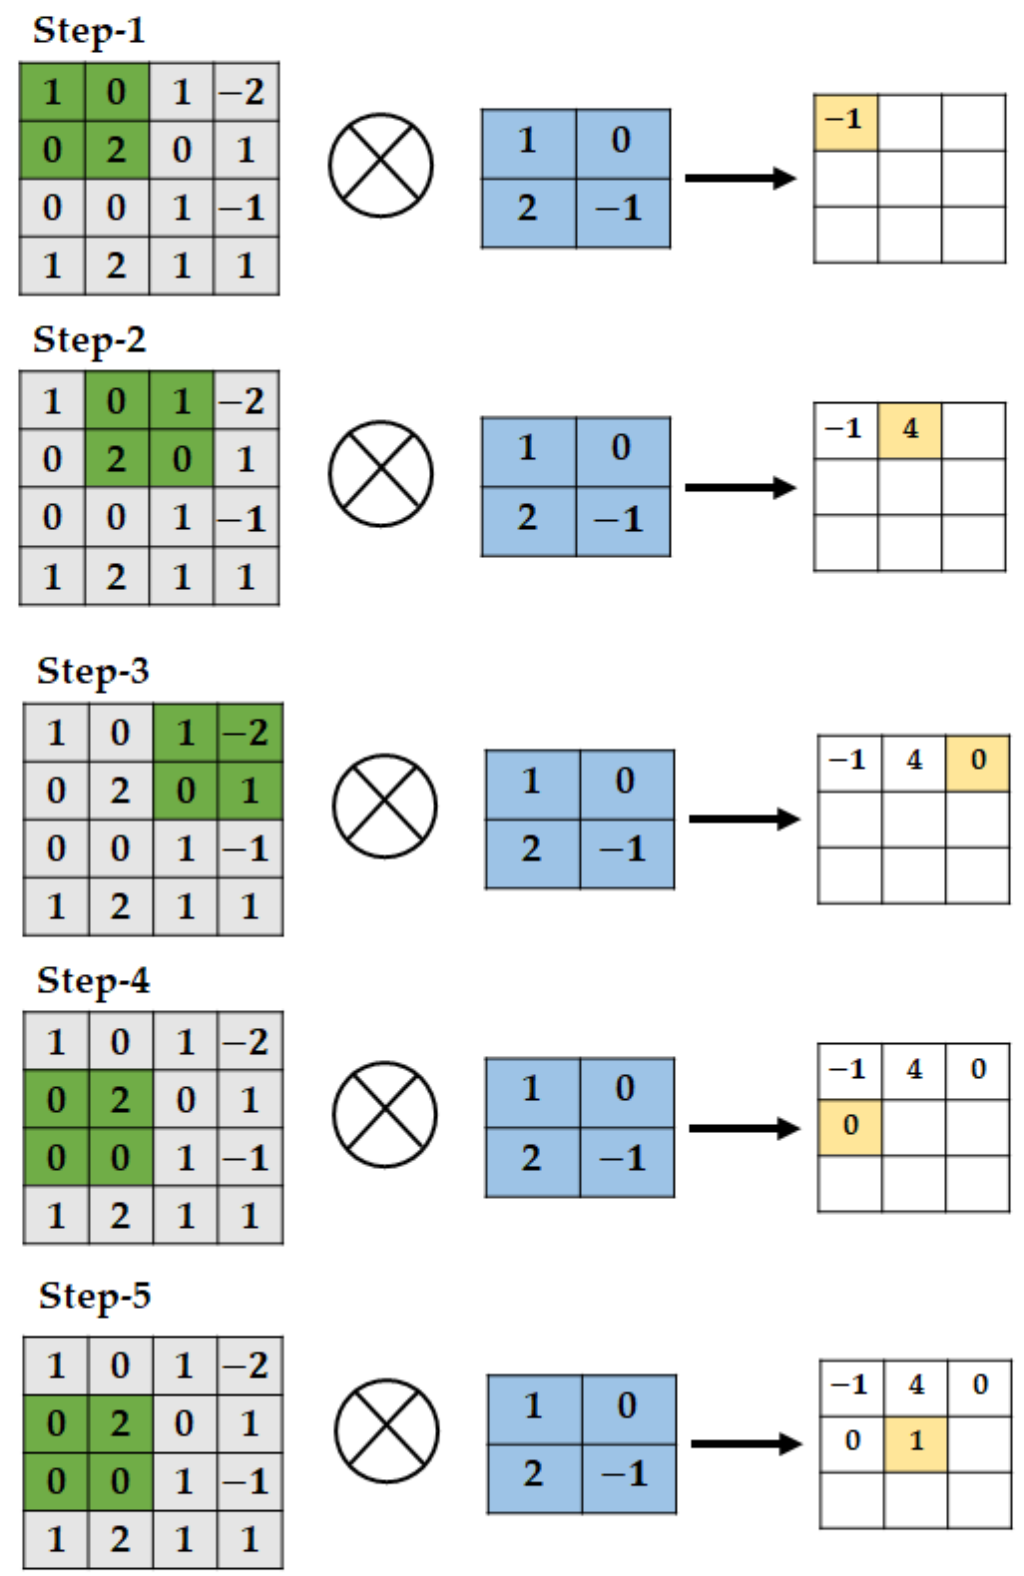
Figure 6. During the operation of the convolutional layer, the process involves sliding the kernel over all the pixels in the image both horizontally and vertically. The feature map of the output is created by performing a dot product between the values of the kernel and the pixel values within the region covered by the kernel, resulting in a single value. 2. Pooling layer: The purpose of the pooling layer is to perform subsampling on the feature maps. A pooling operation transforms a large feature map into a smaller one,